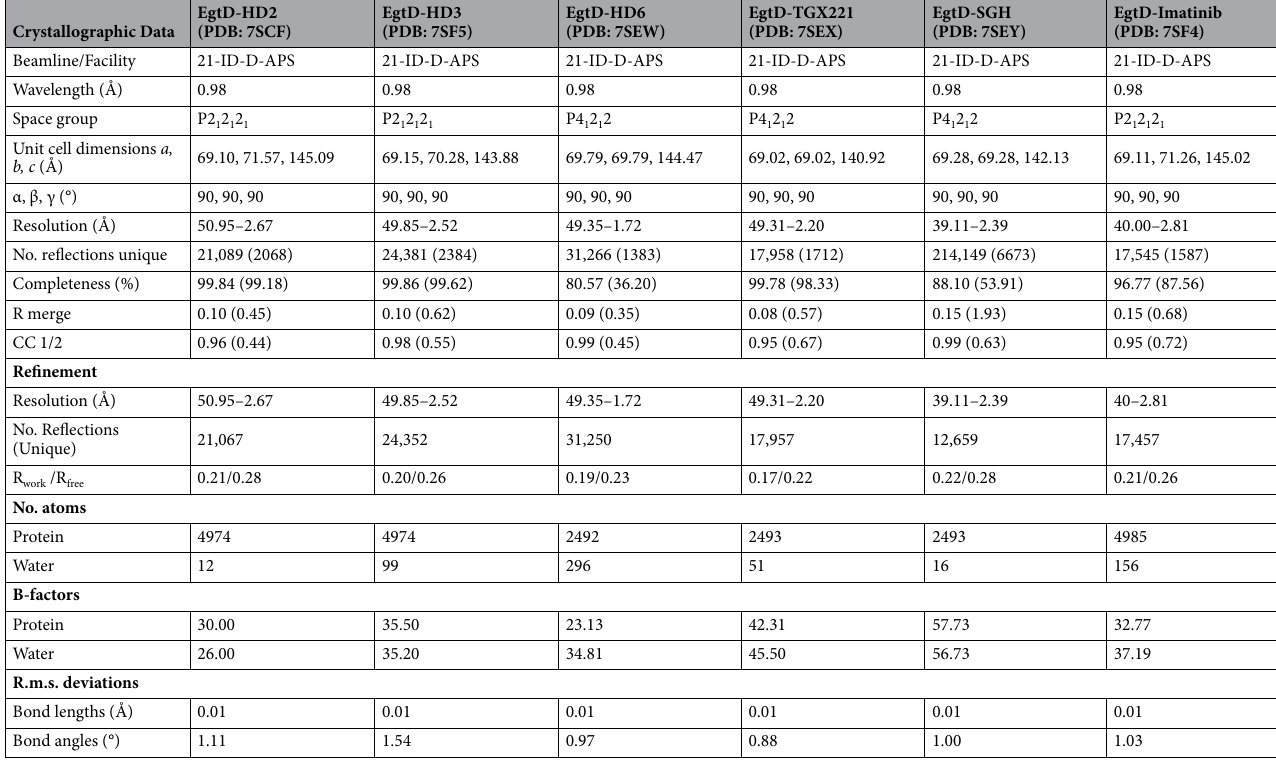
Table 1. X-ray diffraction data collection and refinement